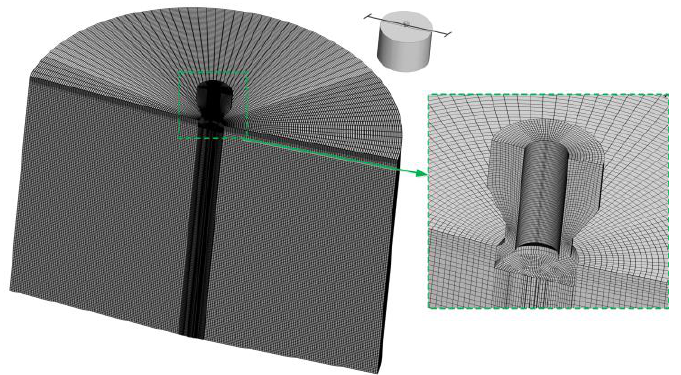
Figure 7. Calculation domain and mesh (taking the push-open conical valve as an example).